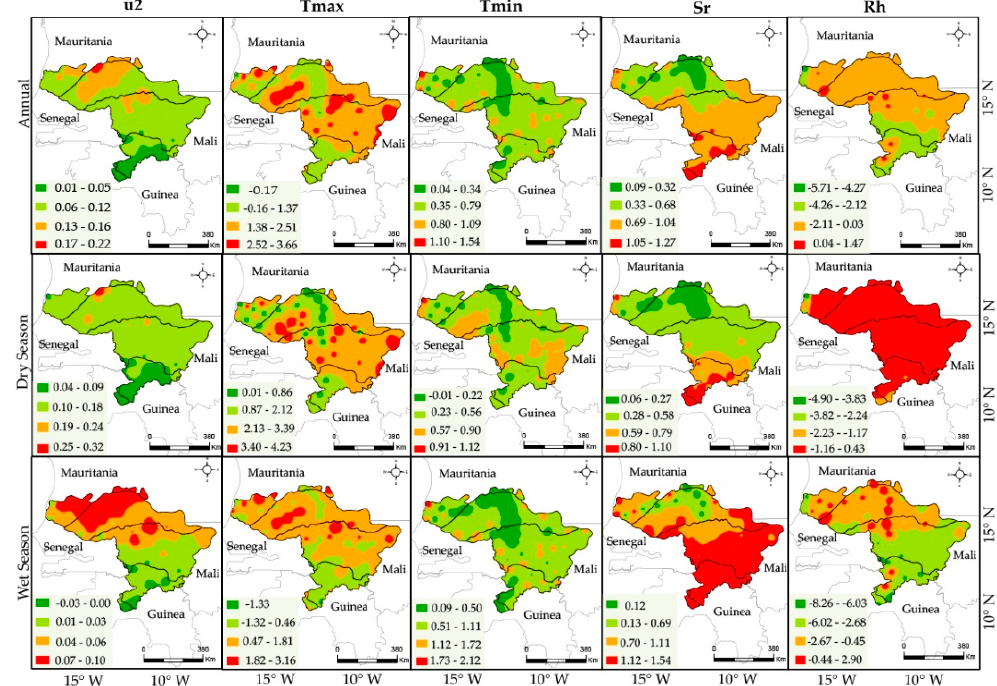
Figure 10. Average sensitivity coefficients of climatic variables over the period 1984 − 2017: u2 wind speed, Tmax maximum temperature, Tmin minimum temperature, Rh relative humidity, Sr Solar radiation.